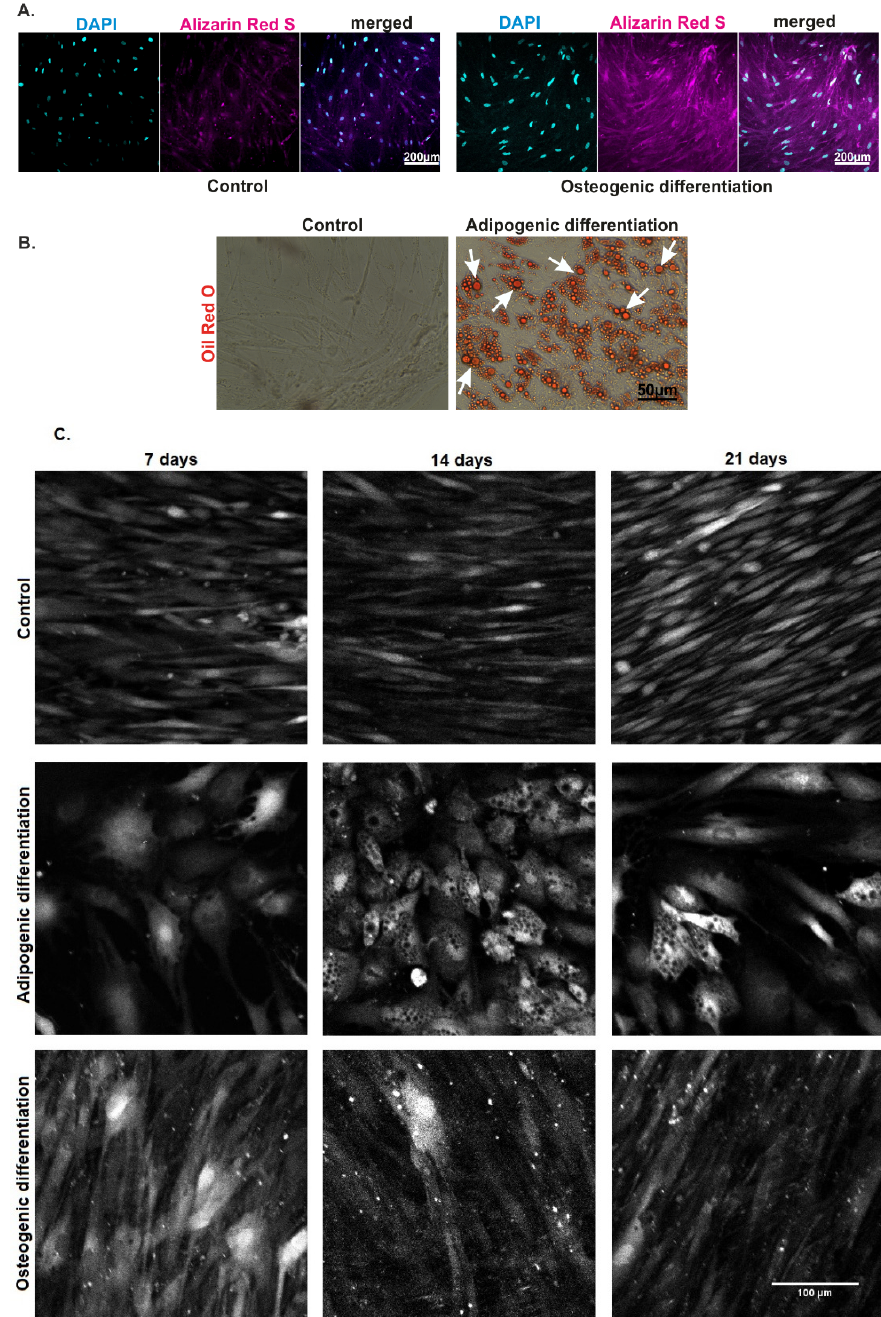
Figure 1. Osteogenic and adipogenic differentiation of ASCs. ASCs were cultivated in standard control medium, or the respective differentiation medium for 7–21 days, followed by staining with DAPI, Alizarin RedS or OilRedO. ( A ) Alizarin RedS staining (magenta) revealed CaPO 4 deposition in cells exposed to the osteogenic differentiation medium, whereas no Alizarin RedS signal was detected in control cells, at 21 DIV. Scale bar: 200 µ m. ( B ) ASCs were exposed to adipogenic differentiation medium or standard medium (control) for 21 days followed by staining of lipid droplets using Oil Red O. Note: Oil Red O-stained lipid droplets in the cells treated with adipogenic differentiation medium (arrows) which was absent under control conditions, at 21 DIV. Scale bar: 50 µ m ( C ) Differentiated and undifferentiated ACSs were loaded with Fluo-4 AM followed by live cell imaging using a 2-photon microscope. Ca 2+ imaging was carried out. The top row shows untreated ASCs. The middle row shows adipogenic differentiation medium-treated ASCs: note the large vacuoles at 14 DIV and 21 DIV. The bottom row shows osteogenic differentiation medium-treated ASCs: note the extracellular deposits at 7 DIV, 14 DIV and 21 DIV. Scale bar: 100 µ m. Subsequently, we assessed the effect of time and differentiation treatment on the Ca 2+ dynamics. These were measured as (1) the fraction of cells showing at least one oscillation among the cells counted in each ROI (Figure 2) and (2) the IPI between two subsequent oscillations within those cells showing oscillations (Figure 3).